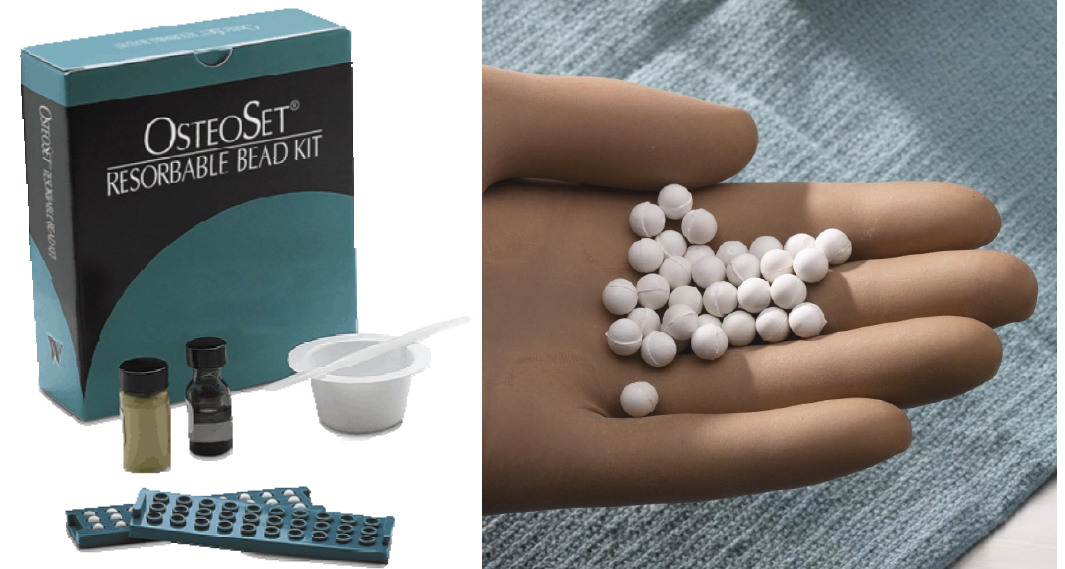
Figure 4. Example of calcium sulfate clinically used for the reconstruction of bone defects (Photo courtesy of Wright Medical